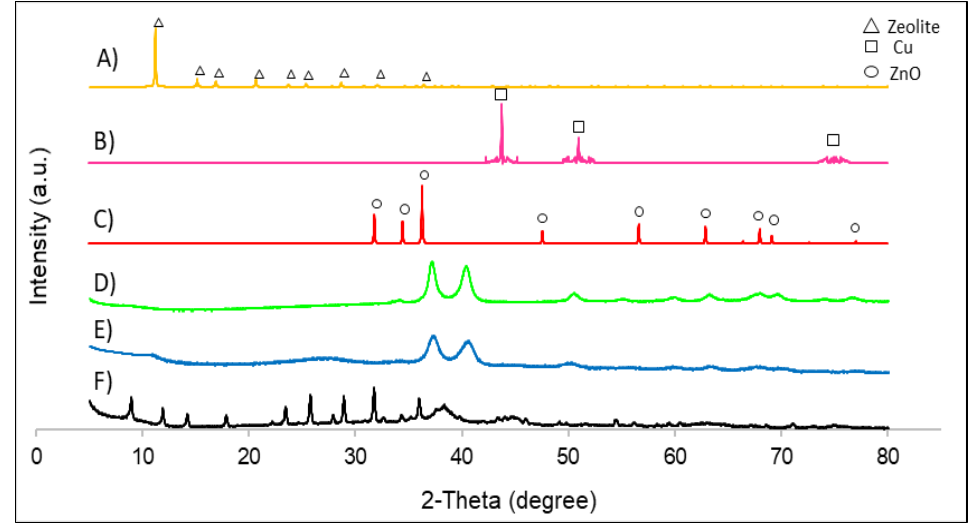
Figure 3. XRD patterns of all catalysts: ( A ) zeolite simulation; ( B ) Cu nanoparticle simulation; ( C ) ZnO nanoparticle simulation; ( D ) Cu/ZnO/polypyrrole nanotubes; ( E ) Cu/ZnO/activated carbon; ( F ) Cu/ZnO/zeolite.